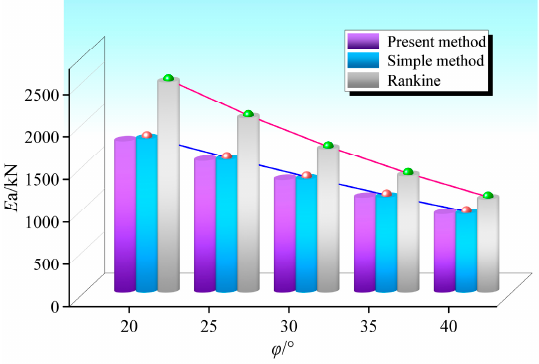
Figure 20. The influence of internal friction angle.